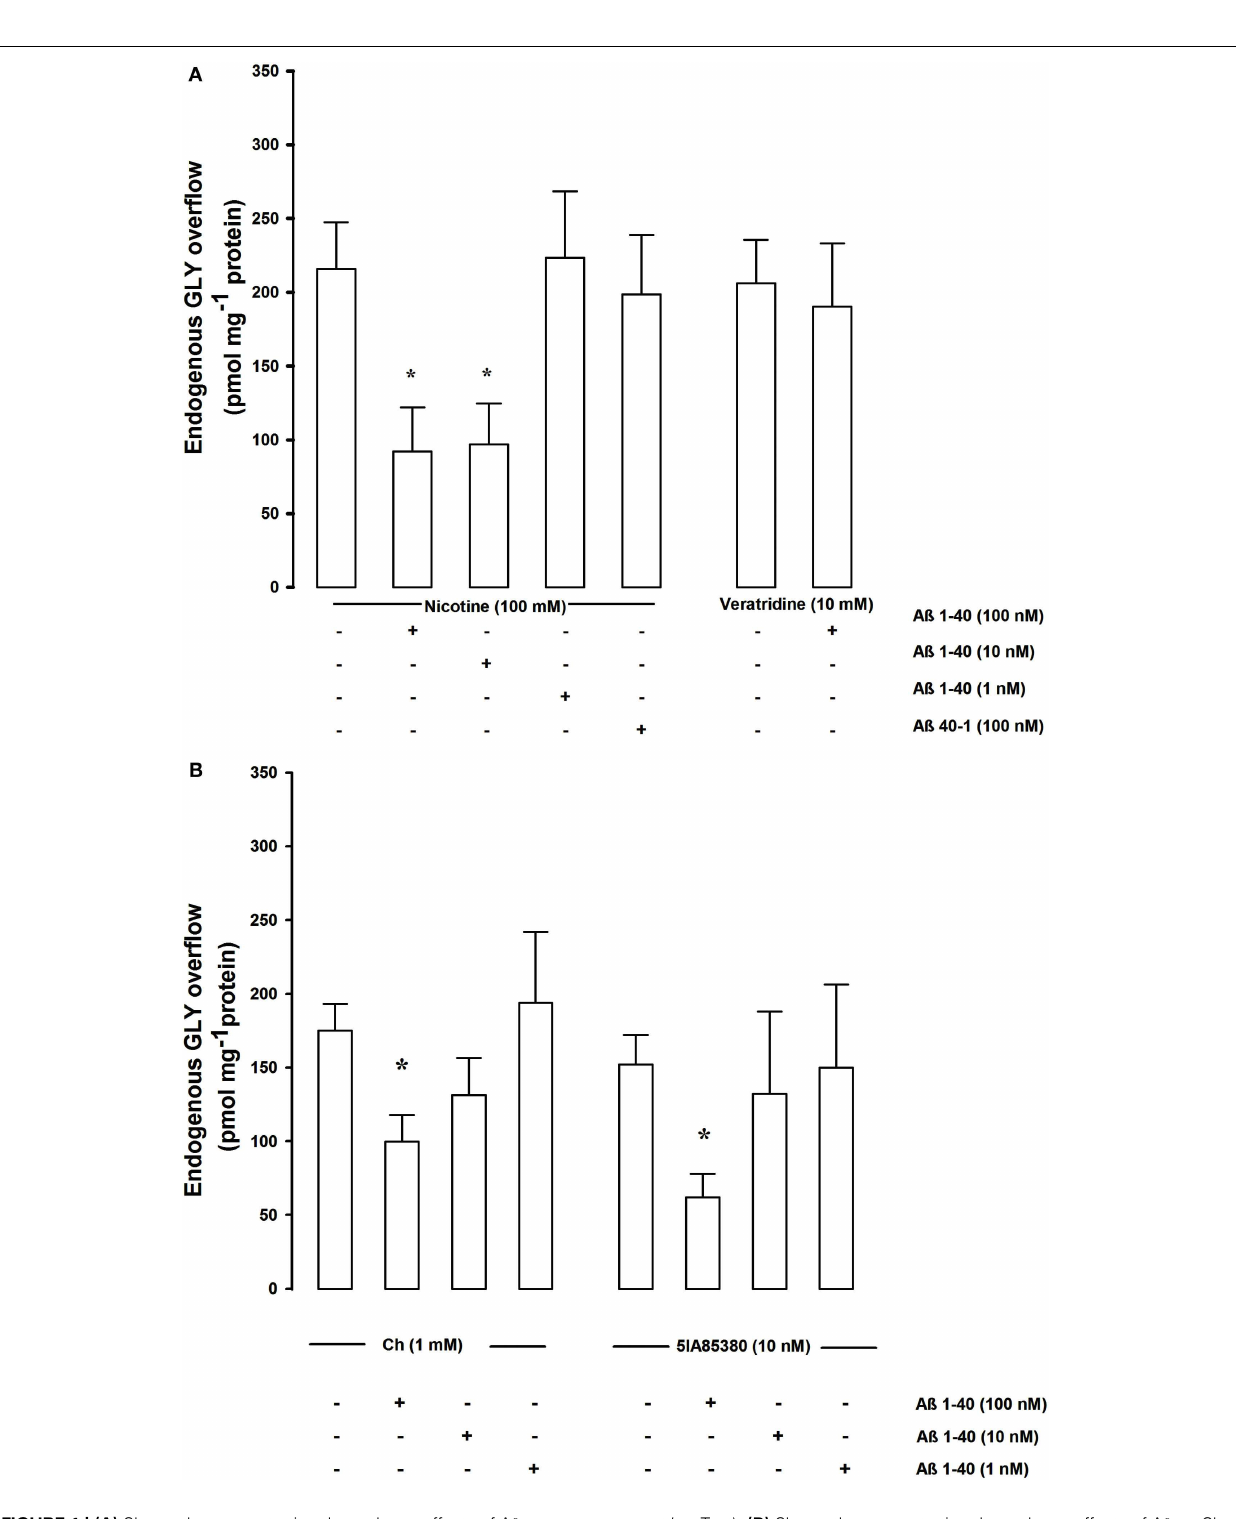
FIGURE 1 | (A) Shows the concentration dependence effects of A β on nicotine- and veratridine-evoked endogenous GLY overflows from rat hippocampal synaptosomes. Data are mean ± SEM of three to six experiments for each concentration run in triplicate. * p < 0.05 versus nicotine-evoked GLY overflow (one-way ANOVA followed by Bonferroni